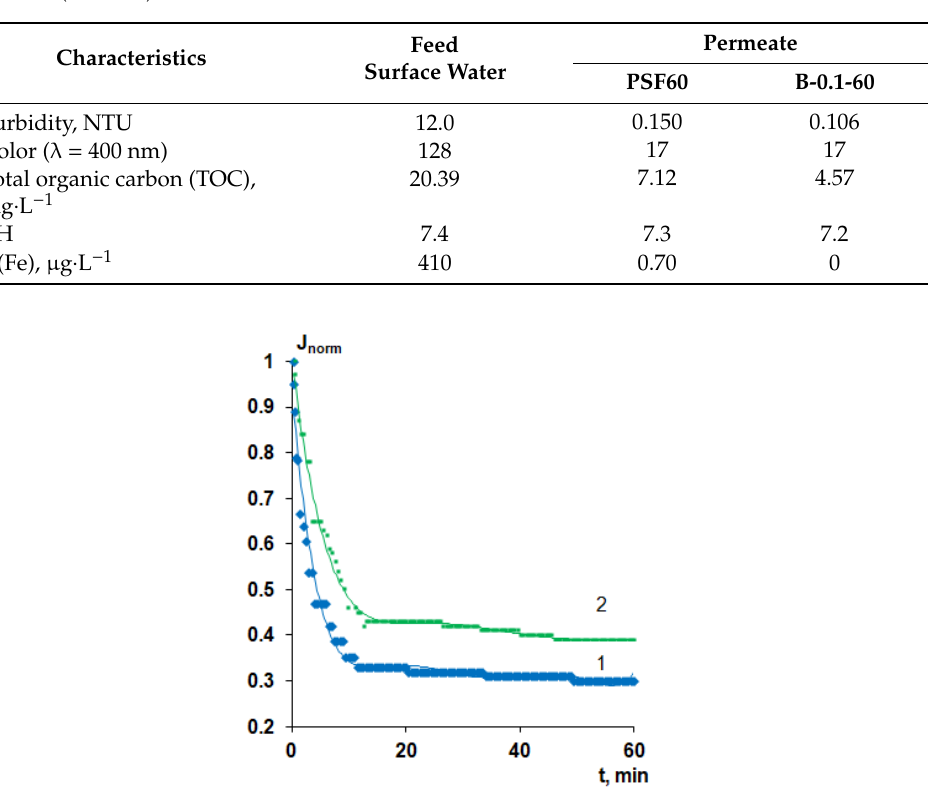
Table 6. Characteristics of feed surface water and permeate using reference (PSF60) and modified membrane (B-0.1-60).